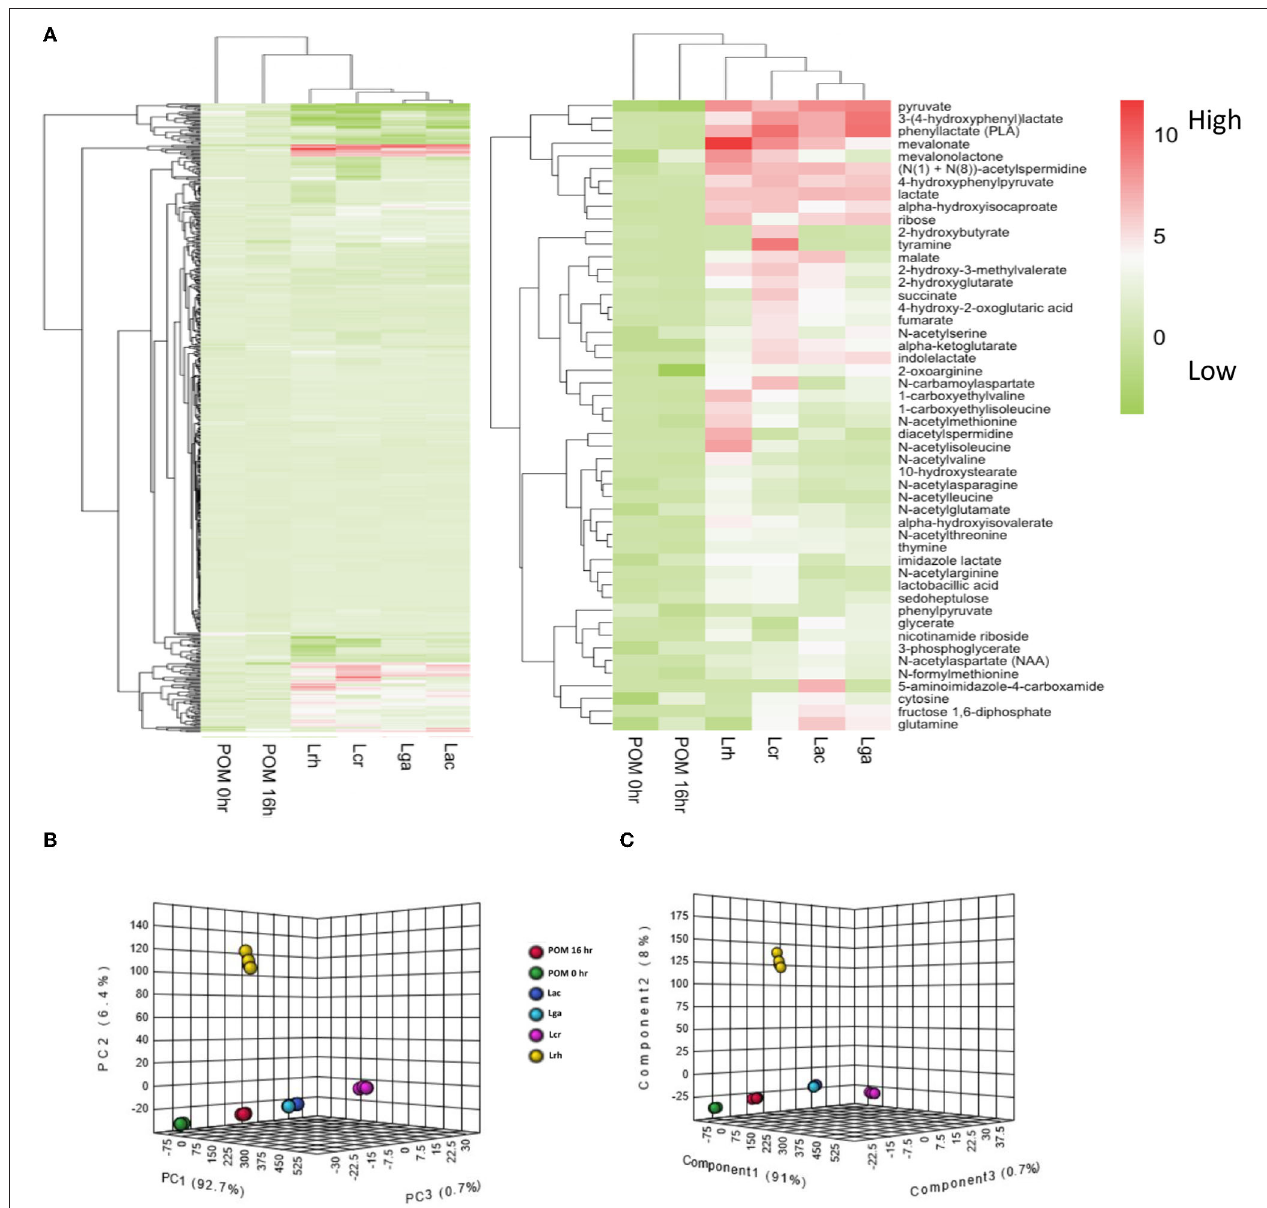
FIGURE 3 | Global metabolomic analysis overview. (A) Hierarchical cluster analysis (HCA) of log2 transformed fold change values of the metabolomic data for the cell-free supernatants of the Lactobacillus strains and controls. The entire metabolite profile (left-hand side) and top 50 significant ( p ≤ 0.05) highest produced metabolites (right-hand side) were performed for each strain. The legend shows the log2 transformed fold change values. (B) Principal component analysis (PCA) and (C) partial least-squares discriminant analysis (PLS_DA) of the global metabolite profile for the four Lactobacillus strains and controls. L. acidophilus NCFM (Lac),